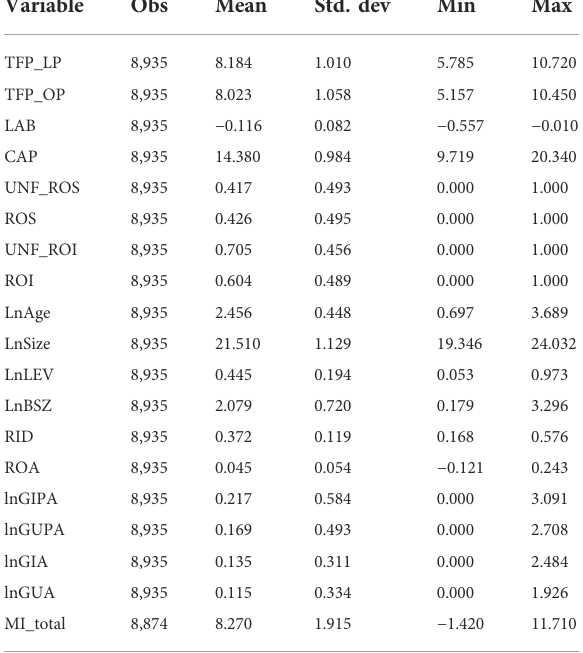
TABLE 4 Descriptive statistics of